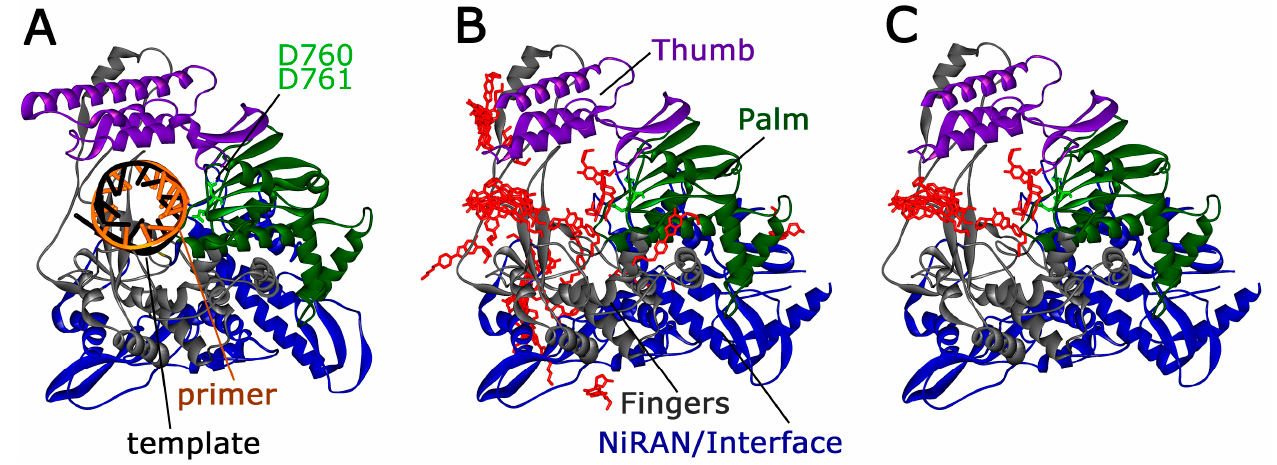
Figure 6. Docking of compound 1 on the RdRp structure. ( A ) The structure of SARS-CoV-2 RdRp in complex with RNA (template strand, black; primer strand, orange) (PDB: 6YYT) [33]. Only the catalytic subunit nsp12 is shown, cofactor subunits nsp7 and nsp8 are omitted for clarity. ( B ) The structure of SARS-CoV-2 nsp12 (PDB: 6M71) [34] was used for molecular docking of compound 1 using the SwissDock web service [35], resulting in 33 binding site clusters; one representative molecule of compound 1 with the highest binding energy was selected for each cluster. ( C ) Predicted binding sites of compound 1 in the RNA-binding channel of RdRp. Representative binding sites were manually selected based on their overlap with the RNA primer–template in the elongation complex (panel A). The nsp12 domains are colored as follows: palm, green; fingers, gray; thumb, violet; NiRAN and interface, blue. The catalytic residues D760 and D761 in the active site of nsp12 are shown in light green as stick models.